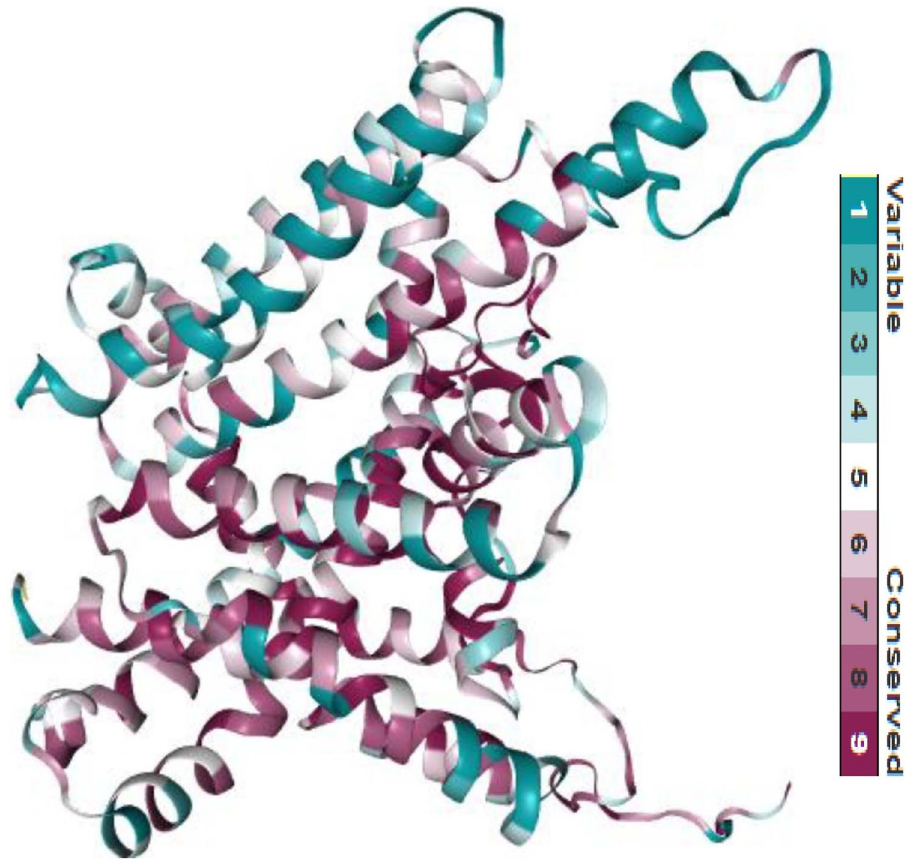
Figure 4. DGAT1 conservation analysis performed using ConSurf and depicting variable as well as conserved residues (score from 1 to 9 based on